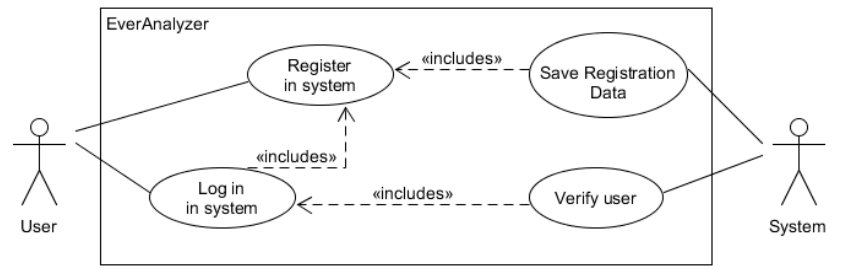
Figure 7. Use Case diagram of EverAnalyzer Objective #1.